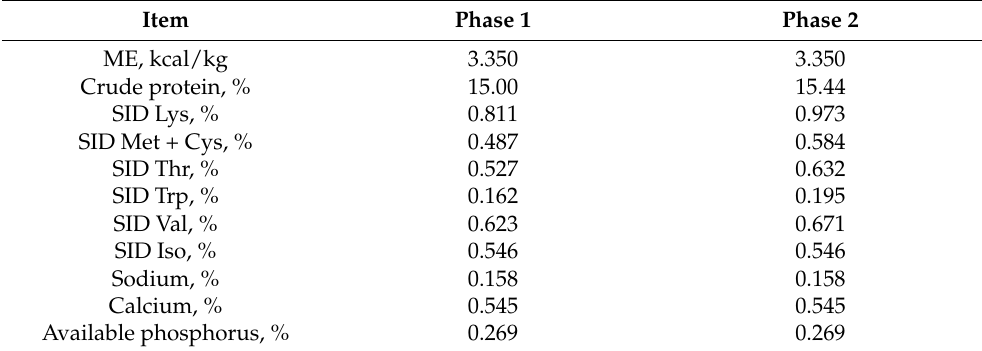
Table 2. Diet calculated nutritional composition 1